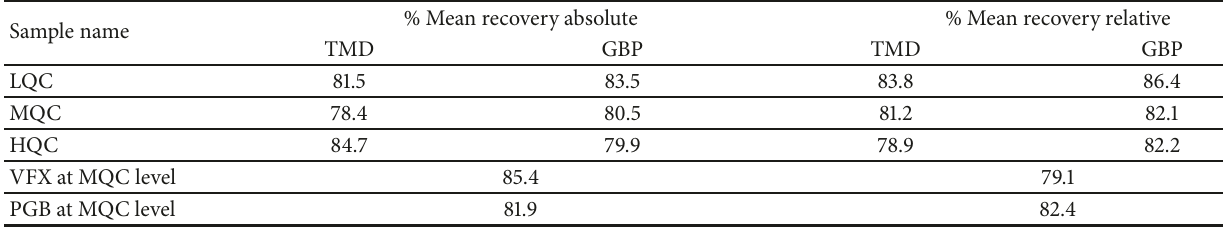
Table 5: Recovery results of TMD and